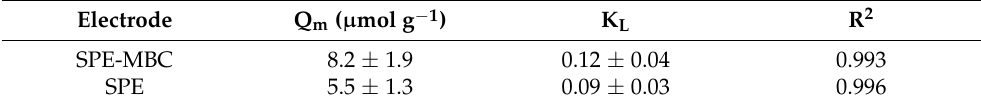
Table 4. Langmuir parameters obtained by fitting DPAdSV data reported in Figure 7b.